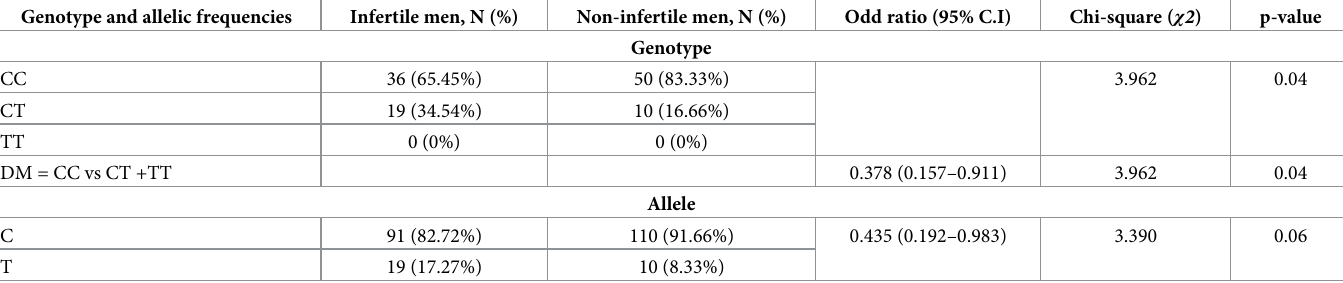
Table 7. Genotypes and allelic frequency in AChE gene SNP rs 17228602 in non-infertile and infertile males. Genotype and allelic frequencies